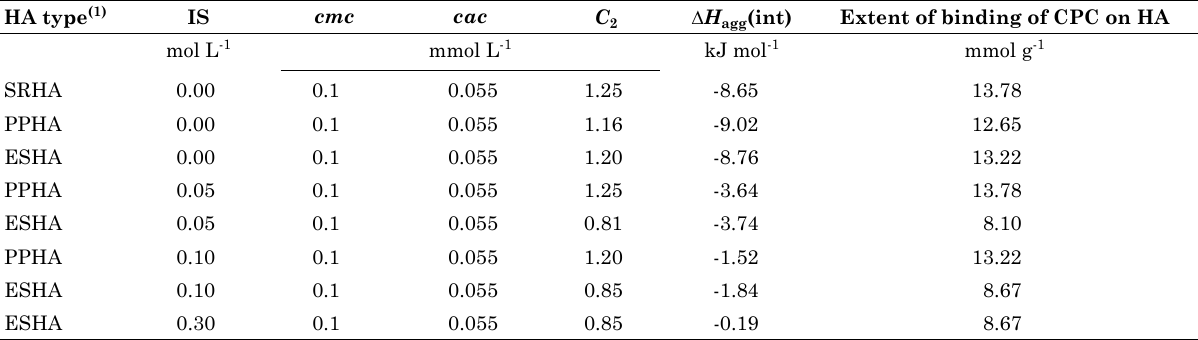
Table 1. Thermodynamic parameters for humic acid-surfactant interactions at different ionic strengths ha type